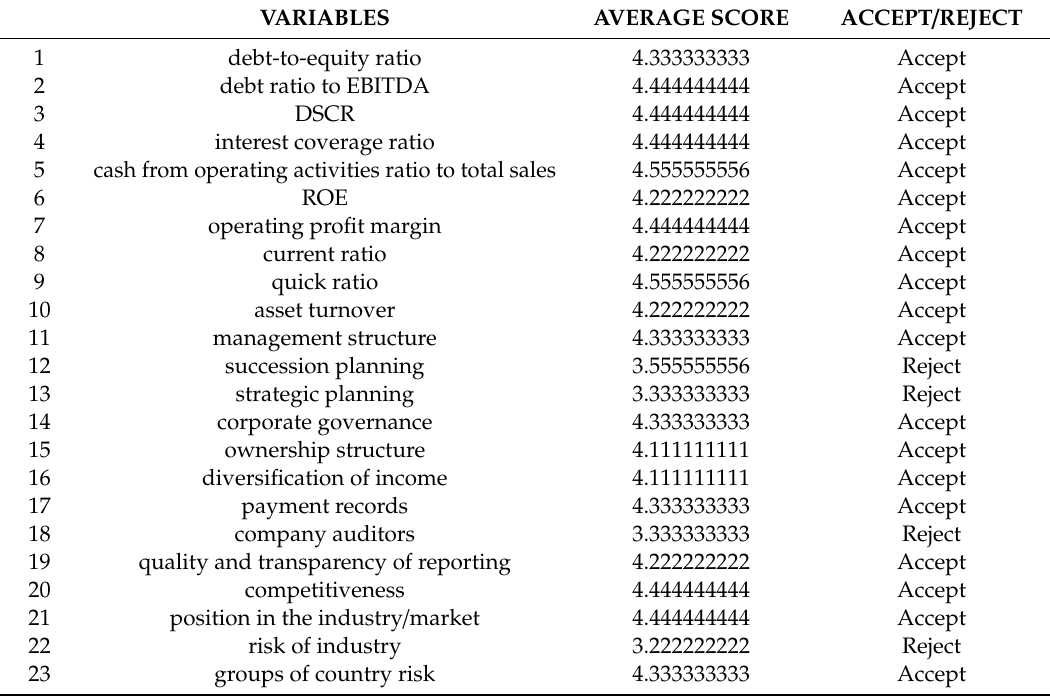
Table 2. Results of the Delphi